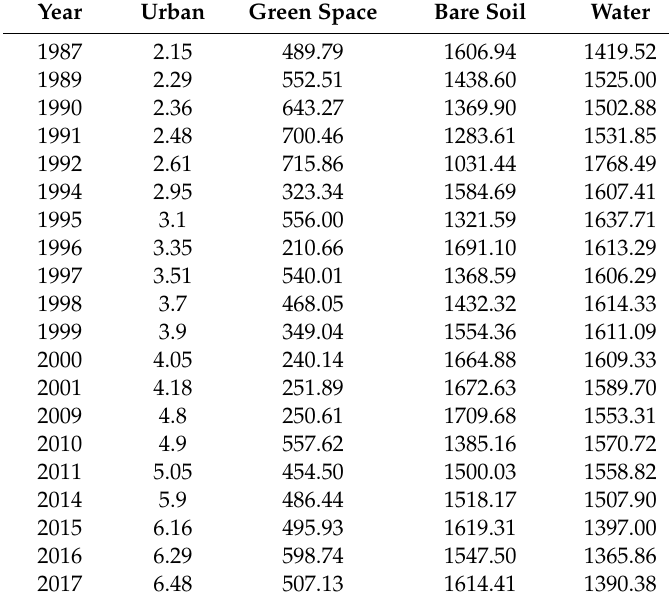
Table 4. Land cover area of the study area for the period of 1987 to 2017 (Km 2 ).